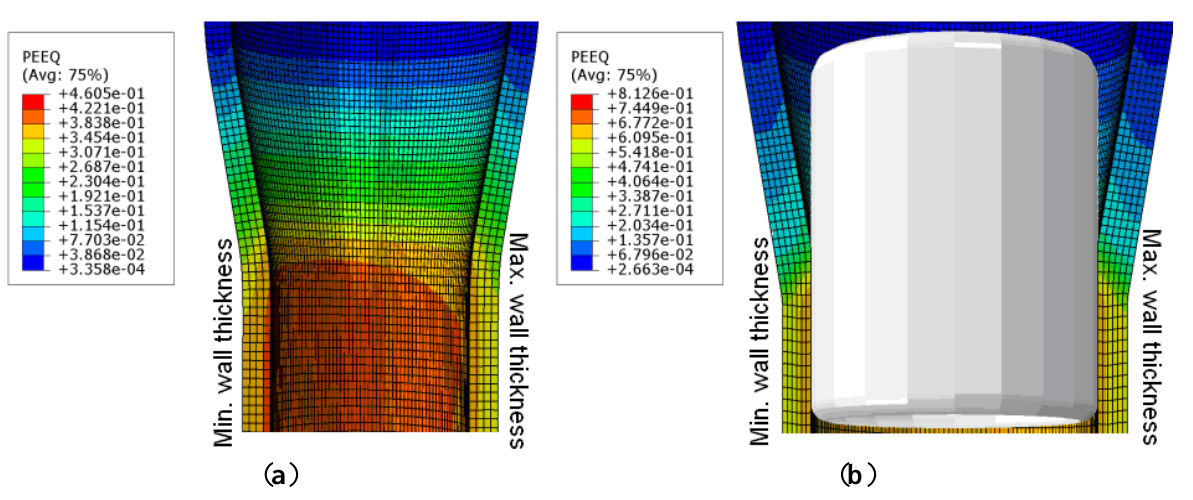
Figure 7. 3D-FEM model for the tubes with contour plot of equivalent plastic strain (PEEQ). ( a ) Without plug and ( b ) with plug.